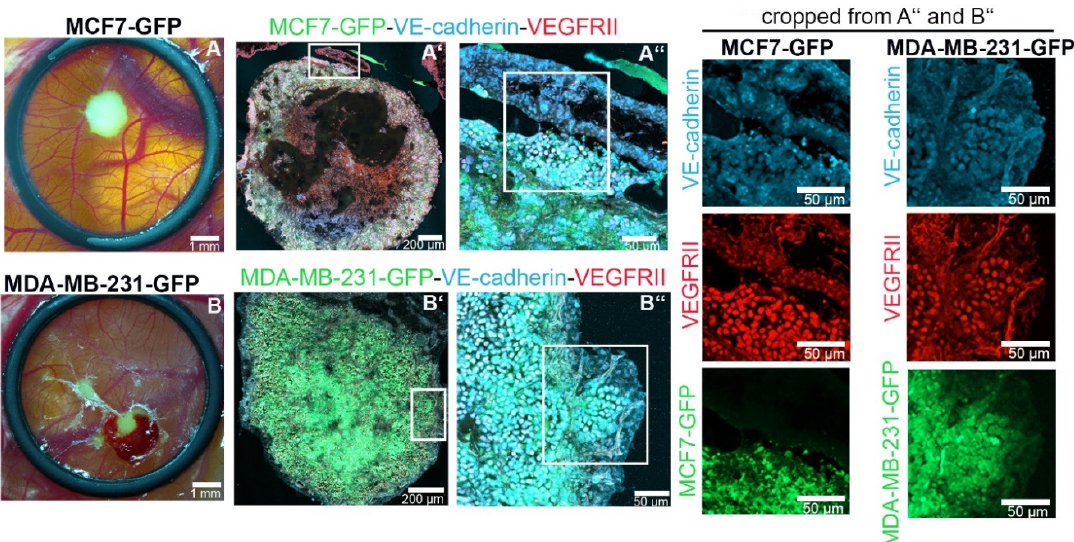
Figure 2. VE-cadherin expression is induced in TCs in the vicinity of endothelial cells (ECs) in vivo. MCF7-GFP (green, in ( A , A’ , A” )) and MDA-MB-231-GFP (green in ( B , B’ , B” )) cells formed tumors after 7 days of inoculation in a chorioallantoic membrane (CAM) implantation assay. Immunofluorescence staining of tumor cryosections with VE-cadherin (light blue) and VEGFRII (red) is shown. The CAM tissue is seen on the top right corner of the MCF7 and MDA-MB-231 sections in ( A” , B” ), respectively.